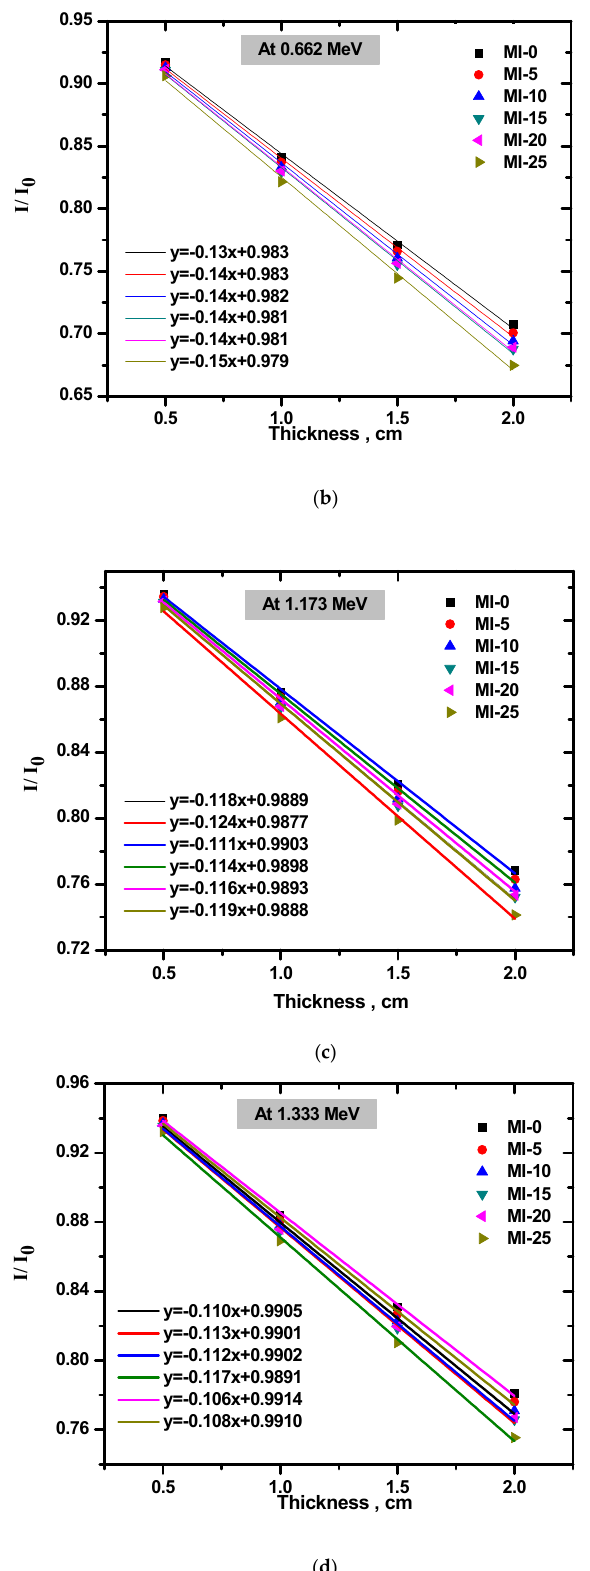
Figure 5. ( a ) The TF of prepared mortar samples at 0.06 MeV with different thicknesses. ( b ) The TF of prepared mortar samples at 0.662 MeV with different thicknesses. ( c ) The TF of prepared mortar samples at 1.173 MeV with different thicknesses. ( d ) The TF of prepared mortar samples at 1.333 MeV with different thicknesses. In Figure 6, we represented the LAC for the reference mortar and the samples with Fe 2 O 3 nanoparticles as a function of Fe 2 O 3. The LAC results display an increasing trend with the addition of Fe 2 O 3 nanoparticles for the four tested energies. The lowest LAC has been reported for the reference mortar (free Fe 2 O 3 nanoparticles) because it is composed of low atomic number elements. In contrast, the highest LAC is found for MI ‐ 25, which contains the maximum amount of Fe 2 O 3 . These results confirm that increasing the ratio of Fe 2 O 3 nanoparticles can lead to a remarkable improvement in the gamma ray shielding. In addition to the impact of Fe 2 O 3 nanoparticles on the LAC, we can see that the energy of the photons is another factor that changes the LAC values. When examining the LAC for a specific composition at 0.06 and 1.333 MeV, we can see a big difference in the LAC values between these two energies. The LAC for MI ‐ 10 (for example) at 0.06 MeV is 0.598 cm − 1 , while it is only 0.1301 cm − 1 at 1.333 MeV. The LAC values at low and high energies for the reference mortar and other mortar samples with Fe 2 O 3 nanoparticles have the same trend as the LAC reported in other studies and for different materials [34–36].